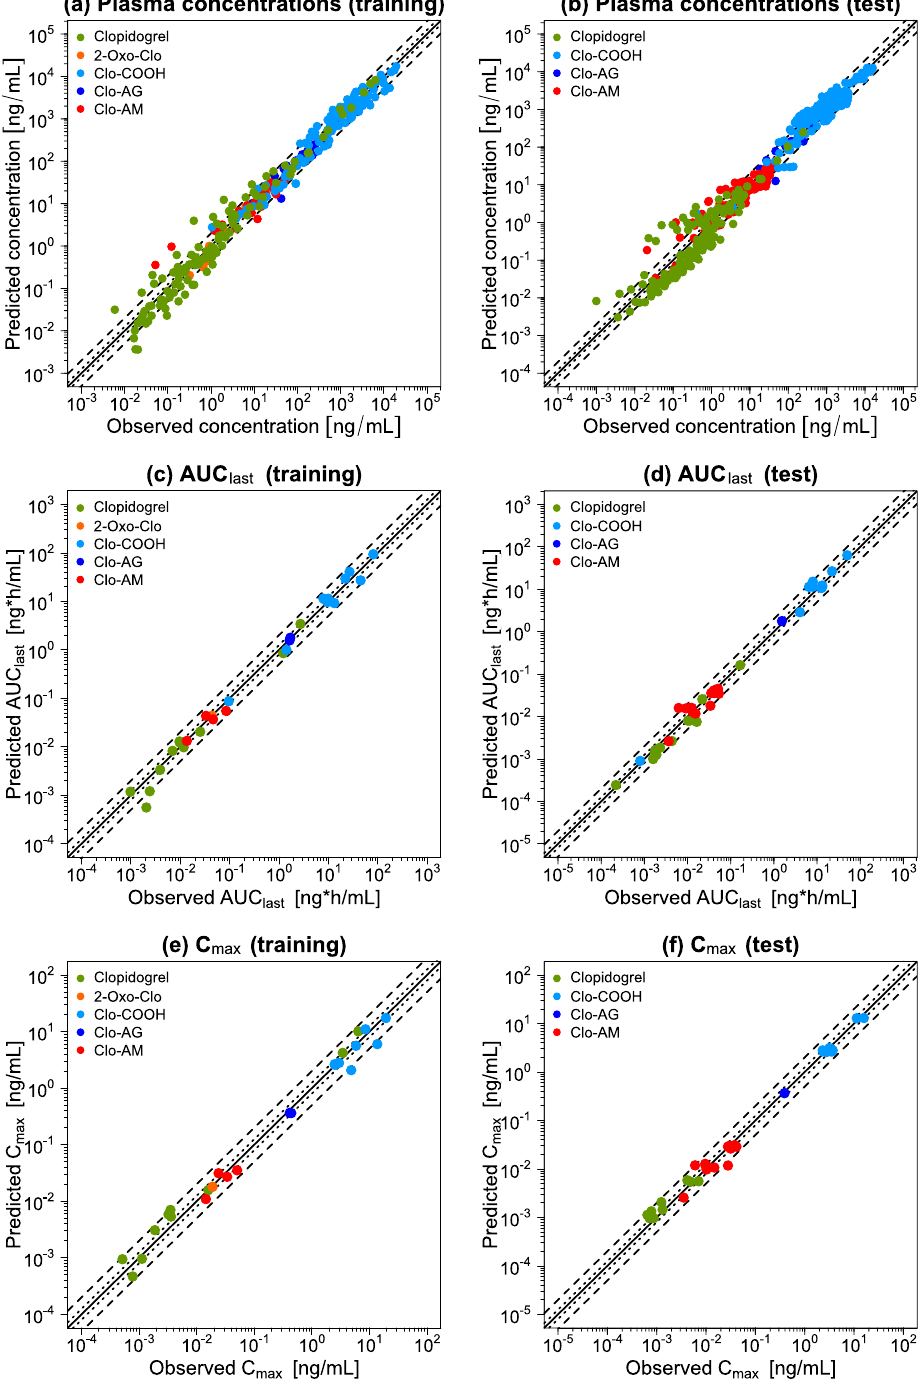
Figure 3. Goodness-of-fit plots of the final clopidogrel parent-metabolite model. Split into training and test datasets, ( a , b ) each predicted plasma concentration as well as predicted ( c , d ) AUC last and ( e , f ) C max values are plotted against their corresponding observed values. The solid line represents the line of identity, while dotted lines indicate 1.25-fold and dashed lines 2-fold deviation from the respective observed value. Detailed information on all profiles and clinical studies can be found in Table S2 of the Supplementary Materials. 2-Oxo-Clo: 2-oxo-clopidogrel, AUC last : area under the plasma concentration-time curve determined between first and last concentration measurements, Clo- AM: clopidogrel thiol H4, Clo-AG: clopidogrel acyl glucuronide, Clo-COOH: clopidogrel carboxylic acid, C max : maximum plasma